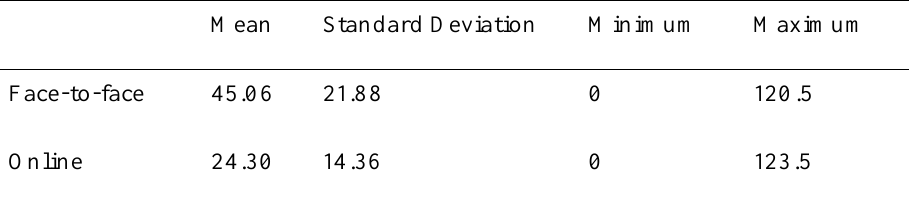
Description of the Variable for Ordinary Credits Passed on the Course Mean Standard Deviation Minimum Maximum Face-to-face 45.06 Online